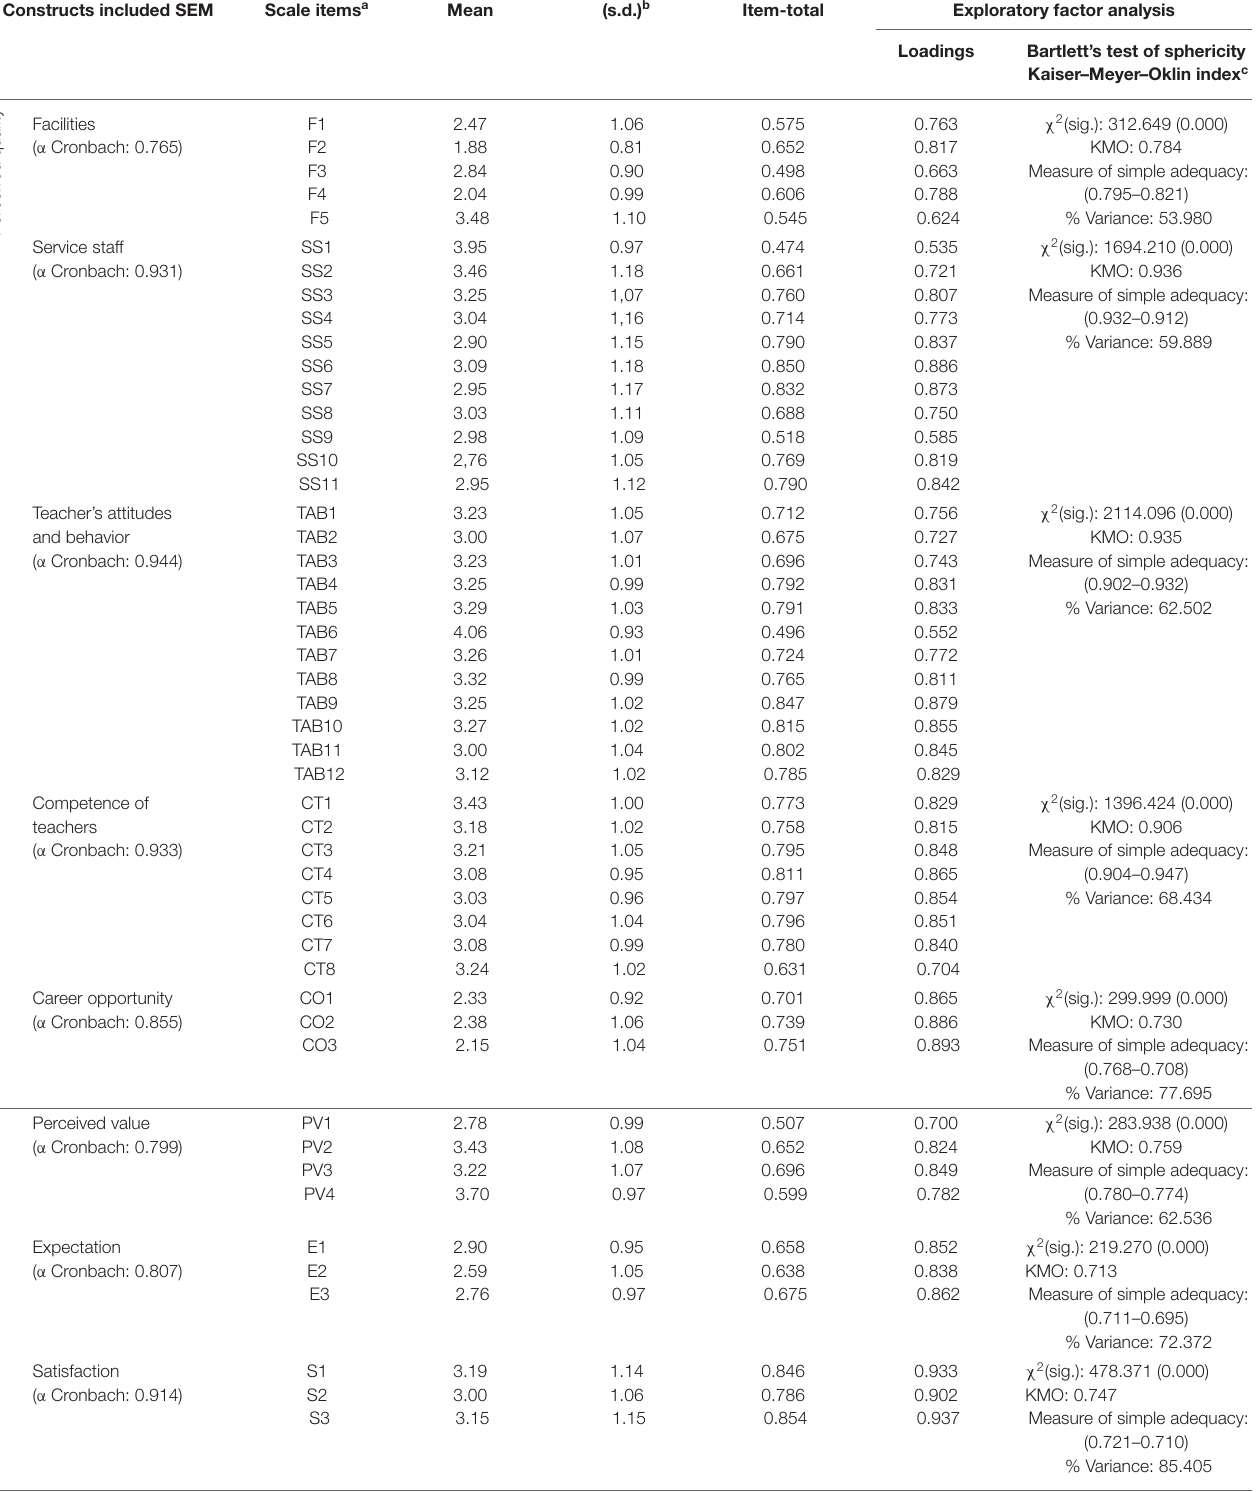
TABLE 1 | Descriptive findings and exploratory factor analysis (reliability and validity of scales). Constructs included